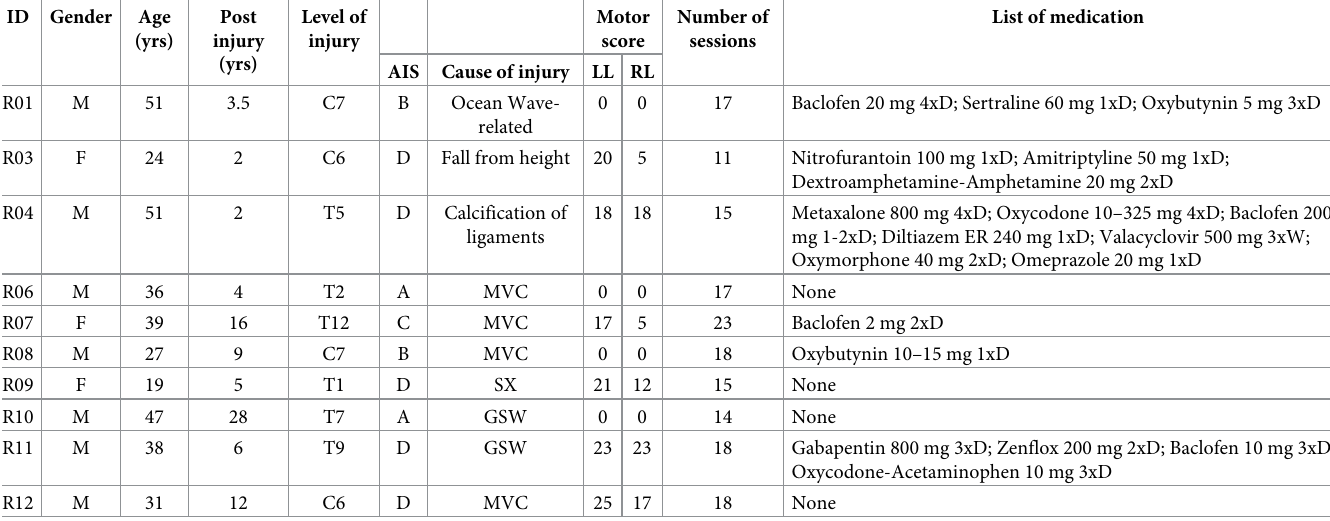
Table 1. Characteristics and demographics of individuals with spinal cord injury (SCI).